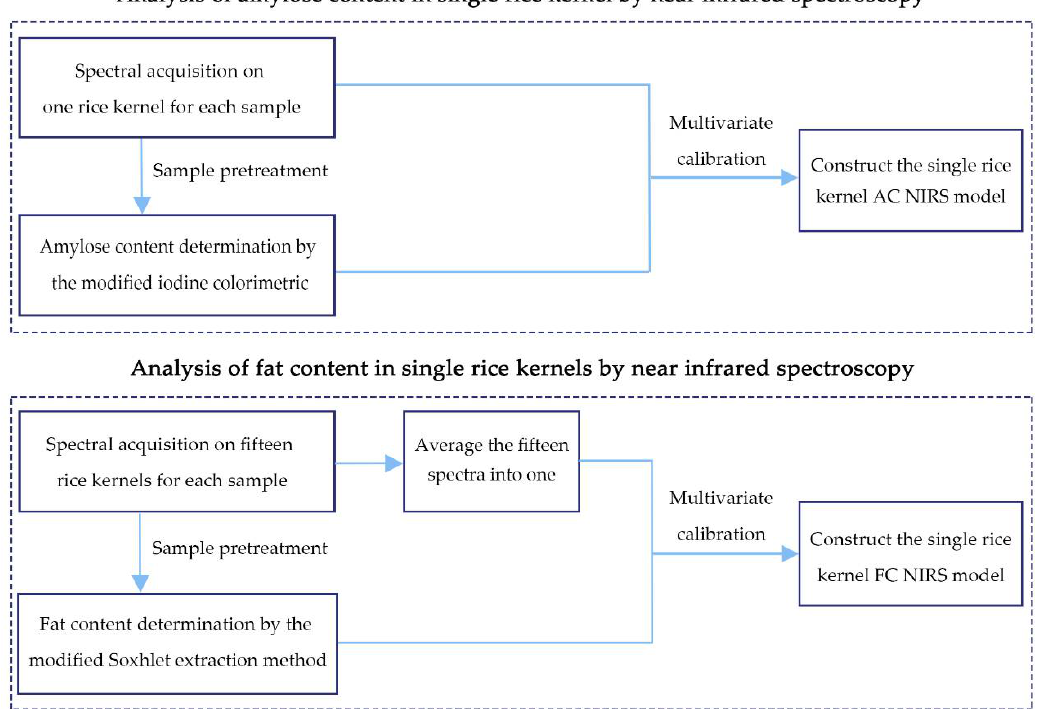
Figure 2. Flow chart of AC and FC detection in single rice kernels based on NIRS.